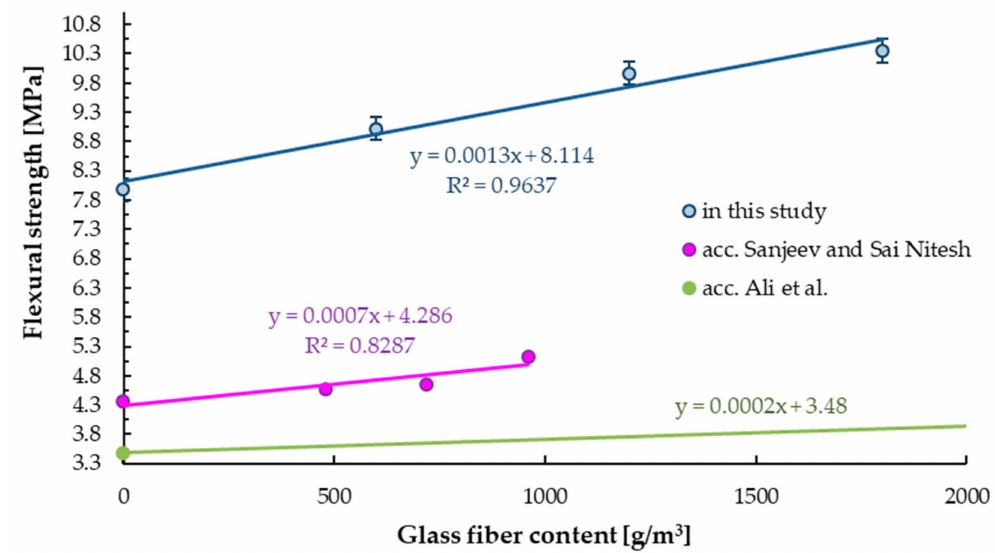
Figure 9. Flexural strength of samples with and without (base mix) glass fibers.